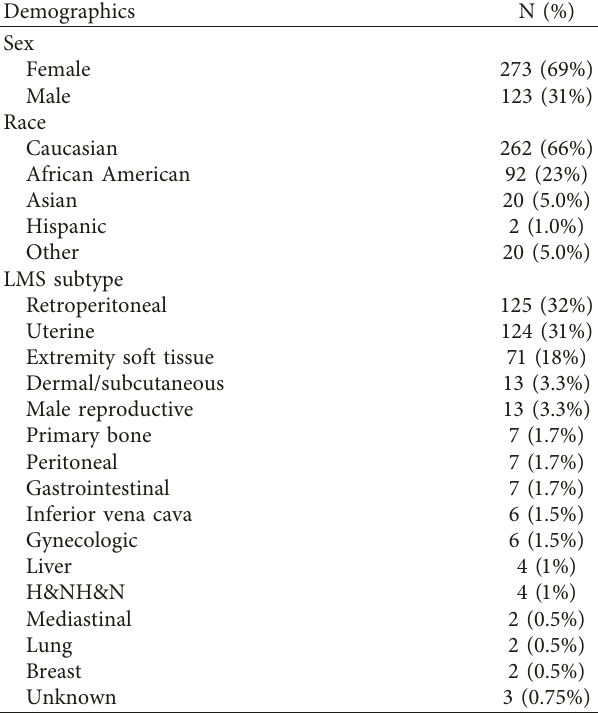
Table 1: Demographics of all 396 patients with biopsy-proven leiomyosarcoma.